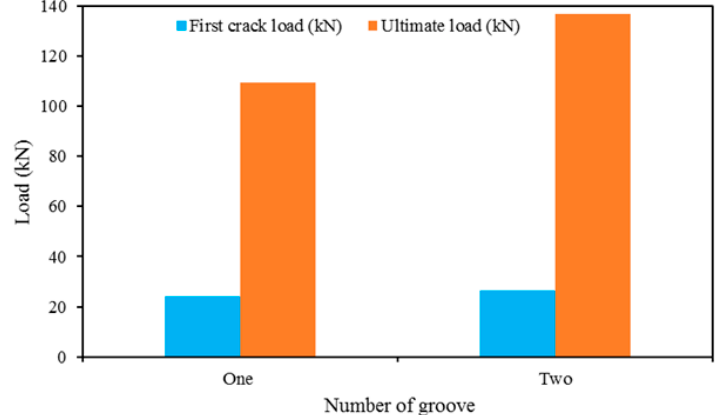
Figure 12. The effect of the number of grooves.